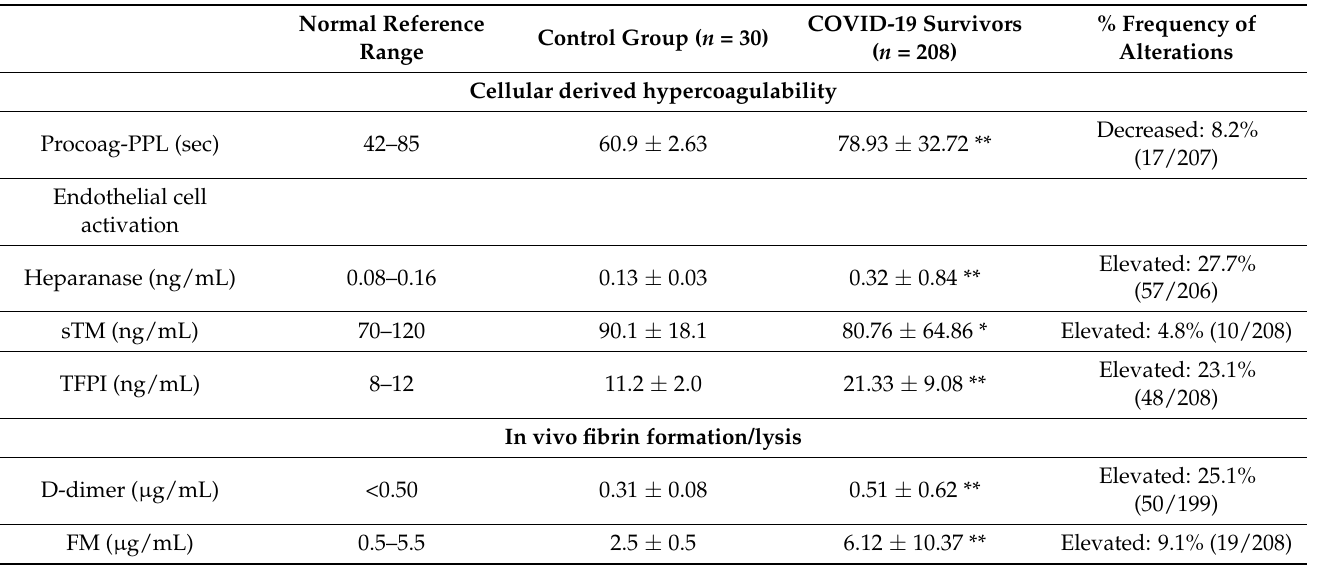
Table 2. Profile of hypercoagulability in the COVID-19 survivors and healthy controls. Values are mean ± standard deviation. ** p < 0.001, * p <